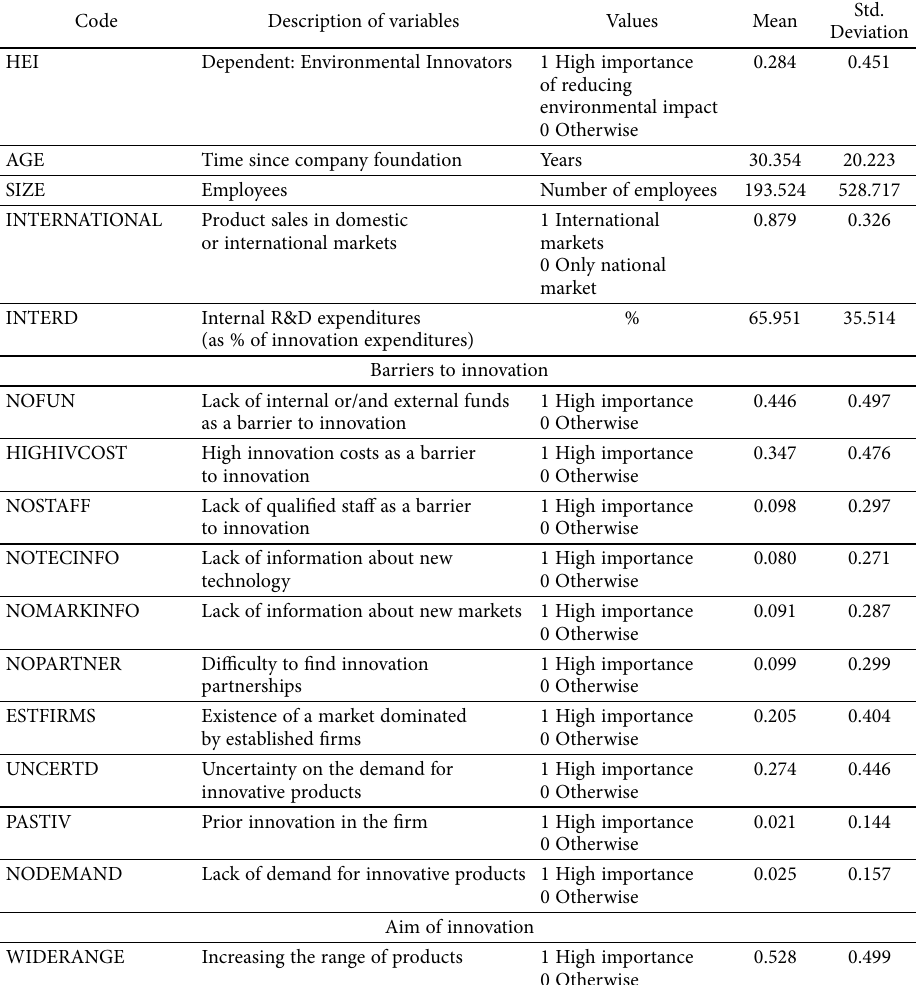
Table A2. Summary statistics and description of the variables used in the